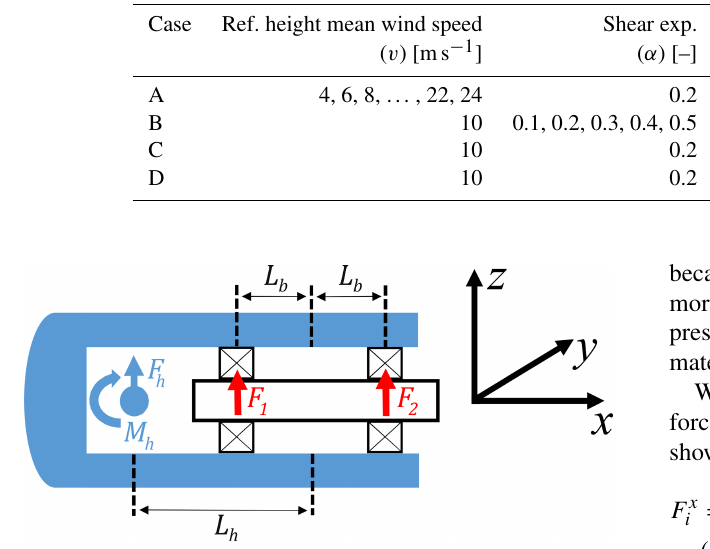
Figure 3. General representation of modelled main bearings and DNV-GL Bladed reference frame. Applied loads, F h and M h , act on the hub at its centre. Main-bearing row force reactions, F 1 and F 2 , are also